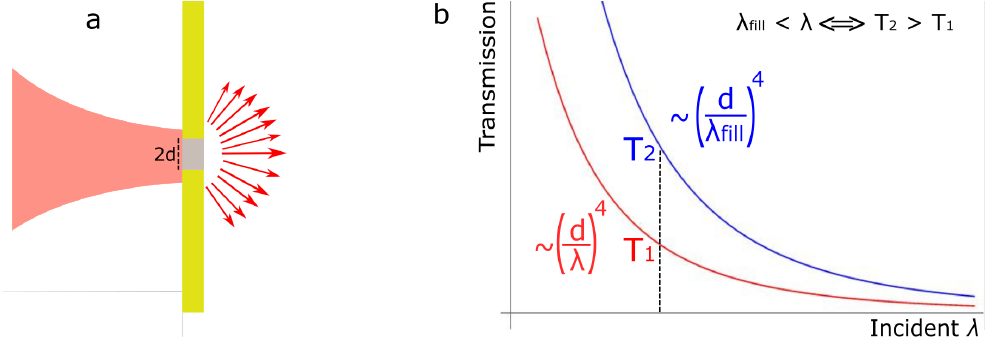
Figure 9. ( a ) The presence of a dielectric material of higher refractive index than the surroundings causes an increase in the transmission of light through the subwavelength aperture. ( b ) Shift of the transmission line due to existence of the dielectric material, leading to higher transmission T 2 , compared to the transmission of light T 1 in the case of non-filling. Figure inspired by